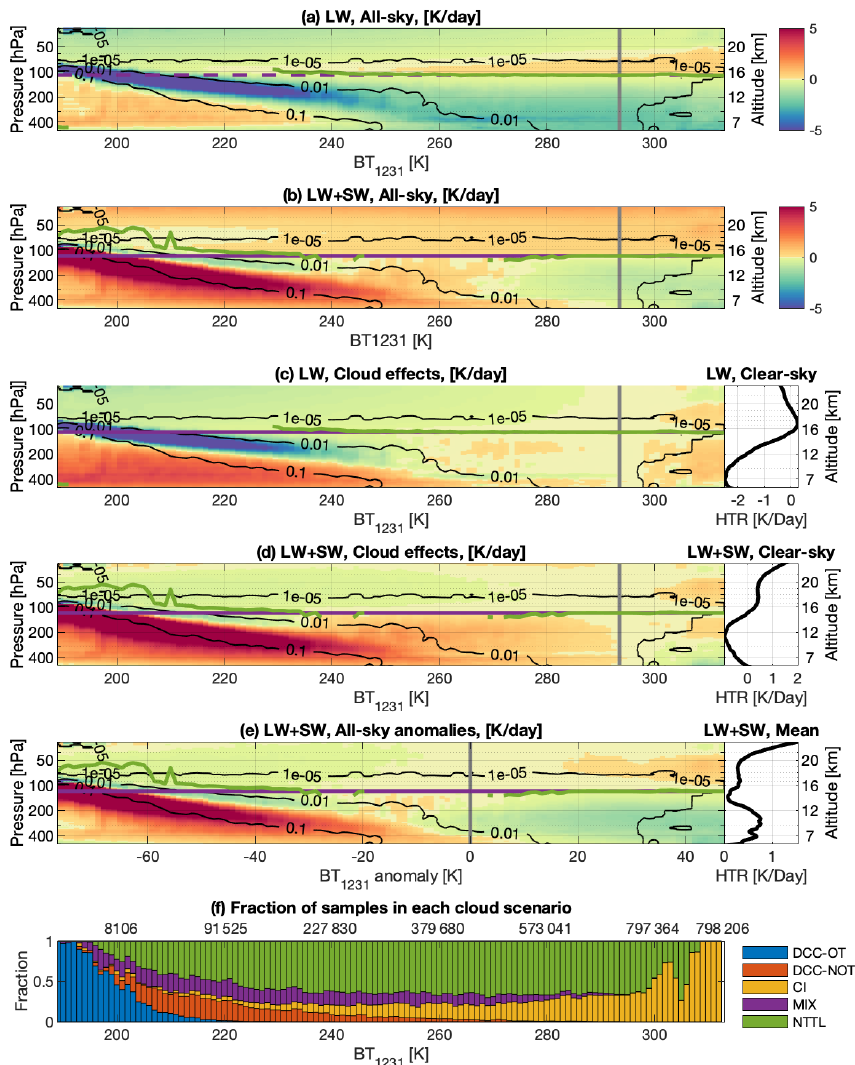
Figure 12. Radiative heating rates (shading, K/d, from CloudSat 2B-FLXHR-LIDAR) and IWC (black contour, g/m 3 , from DARDAR-Cloud) as a function of window band radiance BT 1231 (K, from collocated AIRS L1B). (a) All-sky longwave and (b) net (longwave + shortwave) radiative heating rates. (c, d) The same as (a, b) but for cloud radiative effects, which are defined as the differences between all-sky heating rates and the mean clear-sky heating rate (black curve in the right panel). (e) The same as (d) but for all-sky net radiative heating anomalies, which are defined as the differences between all-sky and the mean all-sky cyclone overpass (black curve in the right panel). (f) The proportion of samples in each cloud category (classified in Sect. 3.1) of all cloudy overpass samples. The numbers at the top indicate the number of cloudy samples with BT 1231 colder than the corresponding temperature marked at the bottom. The magenta line marks the clear-sky LZRH. The green line marks the cloudy-sky LZRH, determined as the vertical position where the heating rate changes from positive to